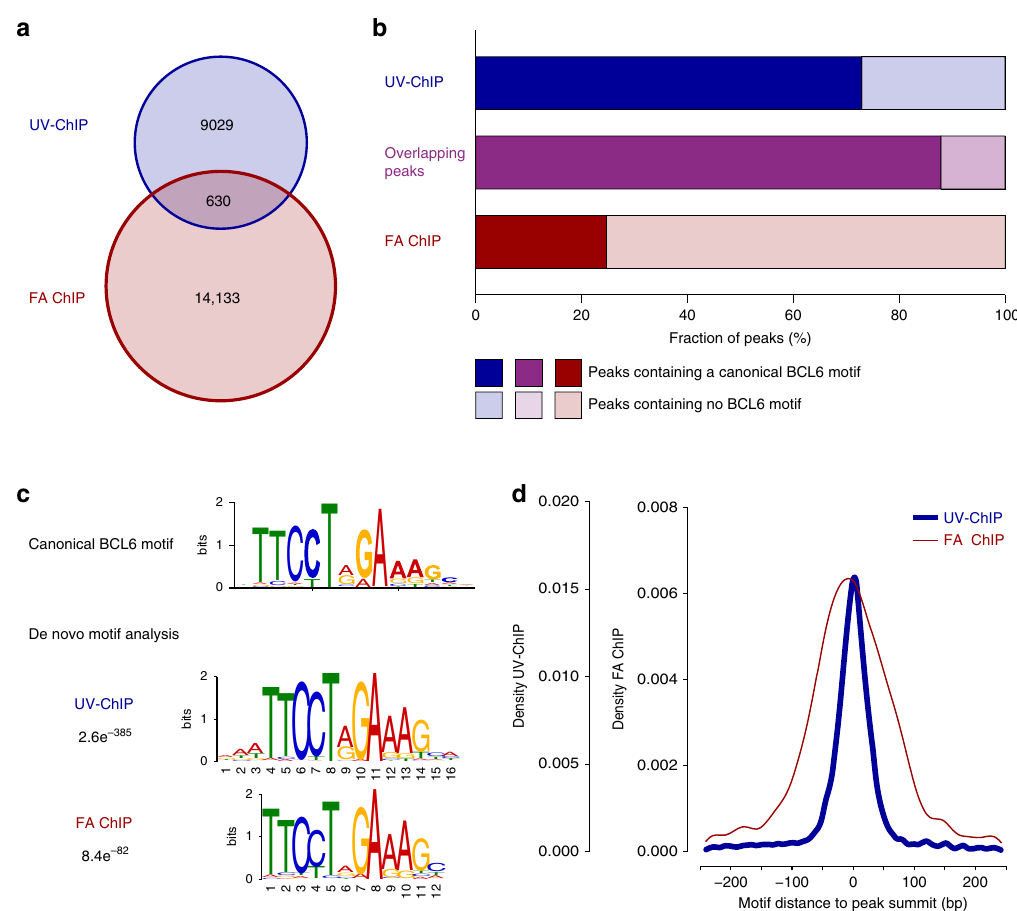
Fig. 2 Binding sites identi fi ed by UV-ChIP-seq are enriched with canonical BCL6 motifs. a Detected BCL6 binding sites (peaks) in human DLBCL cells. The number of BCL6 peaks detected by both UV-ChIP-seq ( n = 9029; blue), FA ChIP-seq ( n = 14,133; red) and the corresponding peak overlap ( n = 630) is shown (see also Supplementary Fig. 9). b Occurrence of canonical BCL6 motifs within detected peaks. The fraction of peaks (%) containing a canonical BCL6 motif ( q -value 0.1, dark colored) and the fraction that does not contain a BCL6 binding motif (light-colored) are plotted for UV-ChIP-seq (72.9% peaks with motif, blue), FA ChIP-seq (24.7%, red) and overlapping binding sites (88.0%, purple). c DNA sequence motif analysis. The canonical BCL6 motif and the corresponding de novo DNA sequence motifs discovered from UV- and FA ChIP-seq data analyses are shown and E -values are indicated (Supplementary Fig. 7). d Distance of BCL6 motifs relative to peak summits. The distance of canonical BCL6 motifs is plotted relative to the corresponding peak summit (base position of maximum enrichment, x axis, ± 250 bp) as detected by UV-ChIP-seq (median ± 18 bp, blue) and FA ChIP-seq (median ± 58 bp,